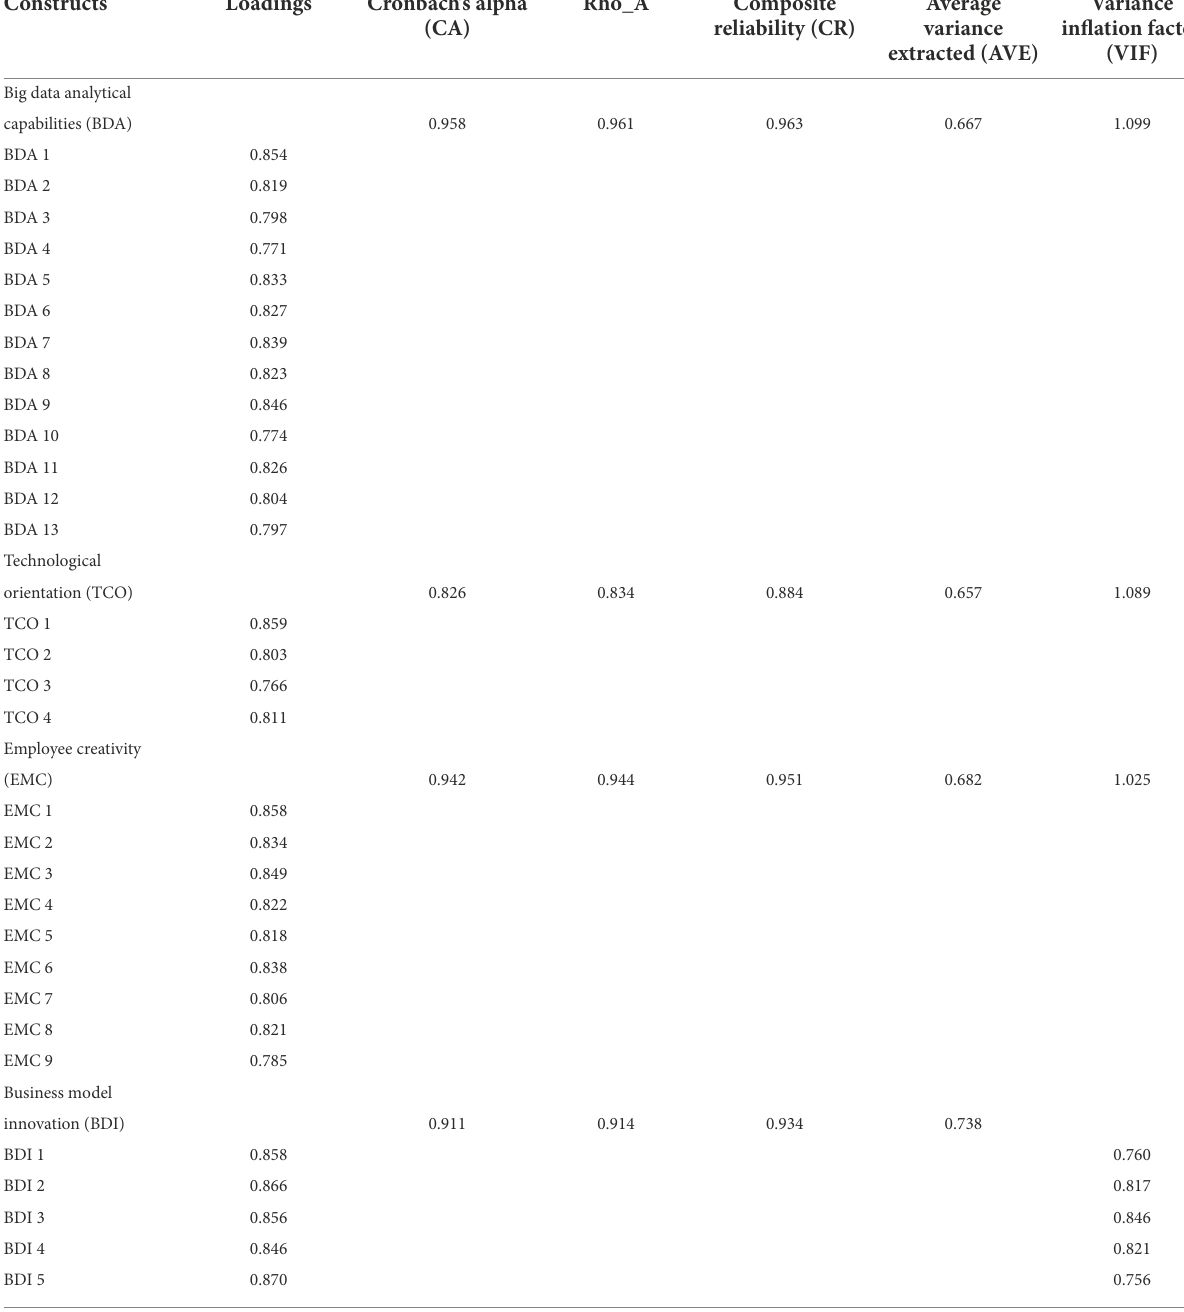
TABLE 2 Factor loadings, reliability, validity and